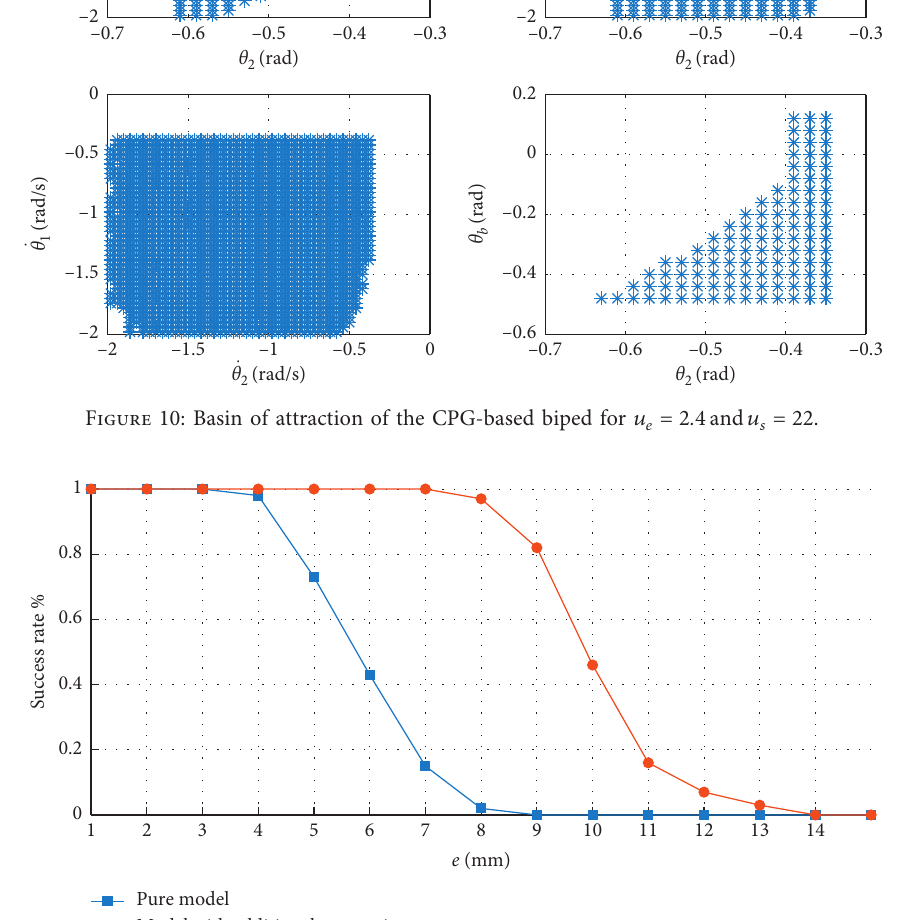
Figure 11: Successful trajectory passing with random height variations with and without the additional connections. Adding the con- nections increased the robustness about 60%.